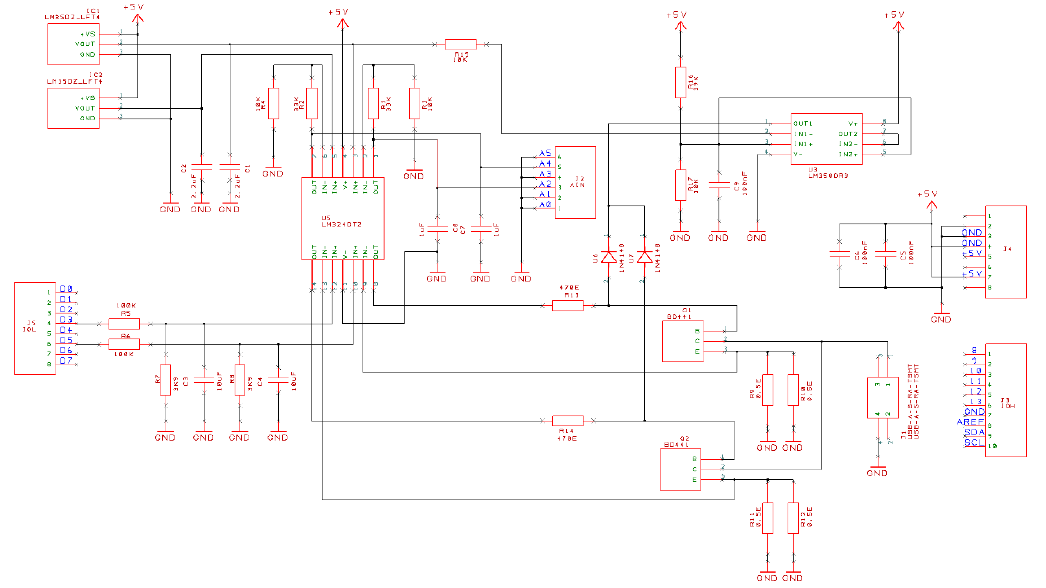
Figure 23. The electronic scheme of the laboratory thermal process connected to Arduino UNO development board.